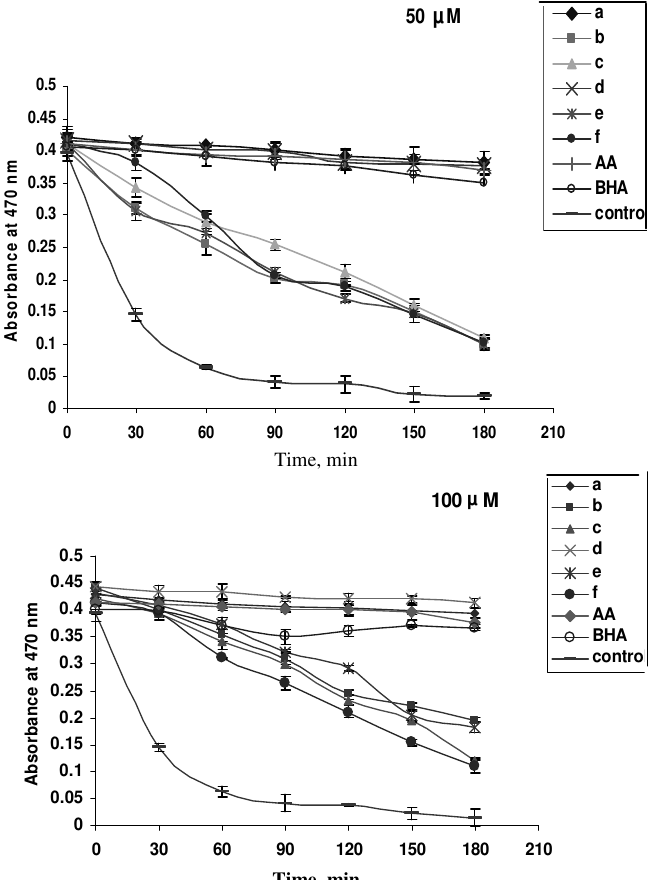
Figure 1. Absorbance change of β -carotene at 470 nm in the presence of compounds a to f , control and positive control (BHA, AA). Each value represents means ± SD (n=3) The control (no additive) are decolourised within 150 min, indicating that rapid oxidation occurred. The addition of compounds a to f and positive controls (BHA and AA) at different concentrations enhanced the bleaching time of β